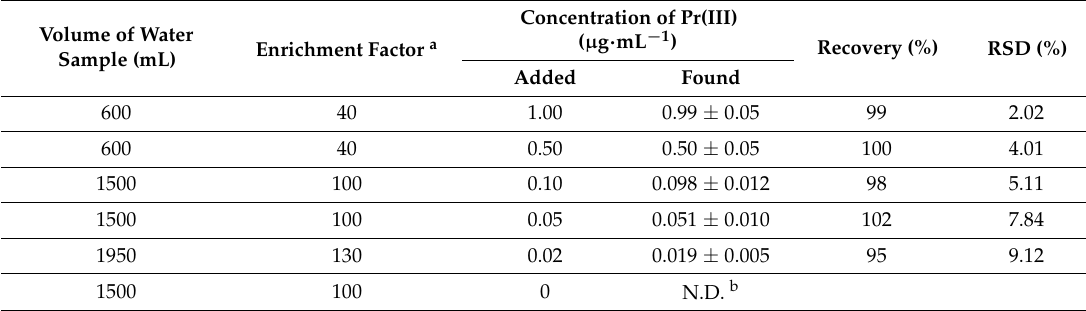
Table 4. Determination of praseodymium(III) ions in the tap water with an additional introduction of Pr(III) ions after preconcentration with clinoptilolite ( n = 3, P =